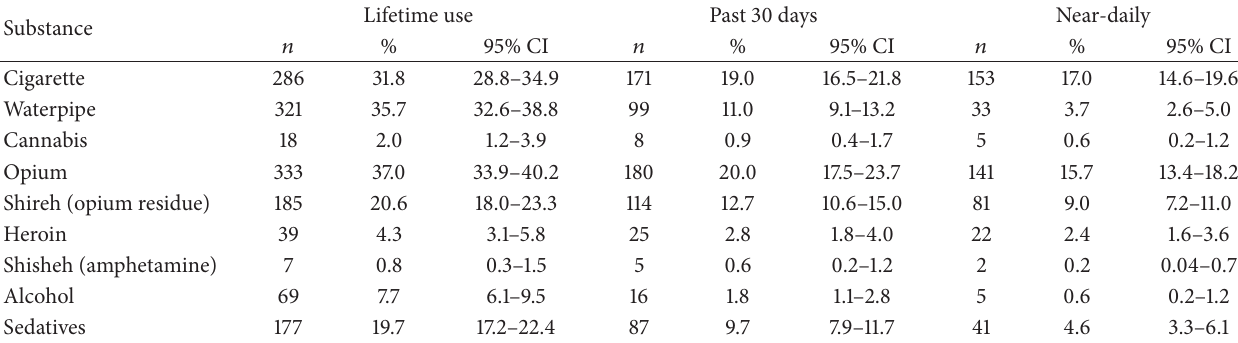
Table 2: Frequency of substance use among rural residents ( 𝑛 = 900 ).